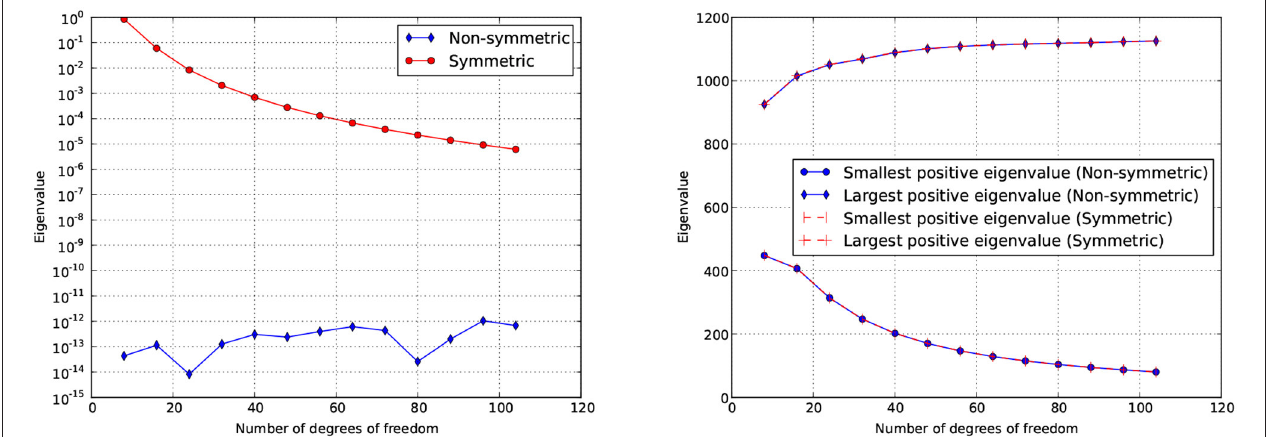
FIGURE 7 | Left : Absolute values of the two equal and small eigenvalues (associated to rigid body translations) of the BEM matrices A and ˜ A for a mesh refinement. Right : The largest and smallest positive eigenvalues of A and ˜ A for a mesh refinement.